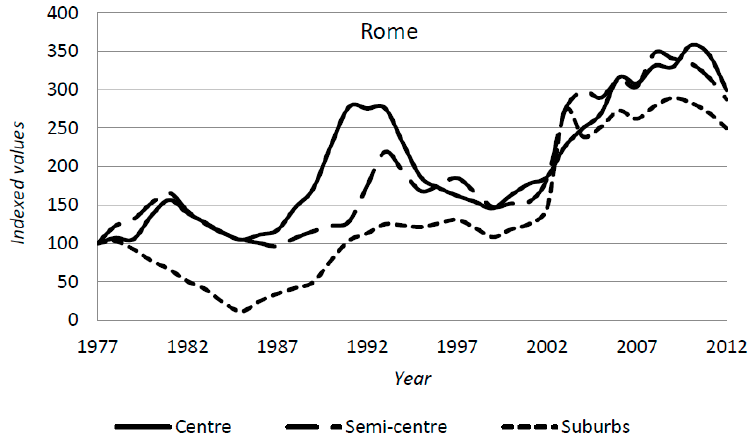
Figure 3. Trend of urban land values from 1977 to 2012 in Rome.